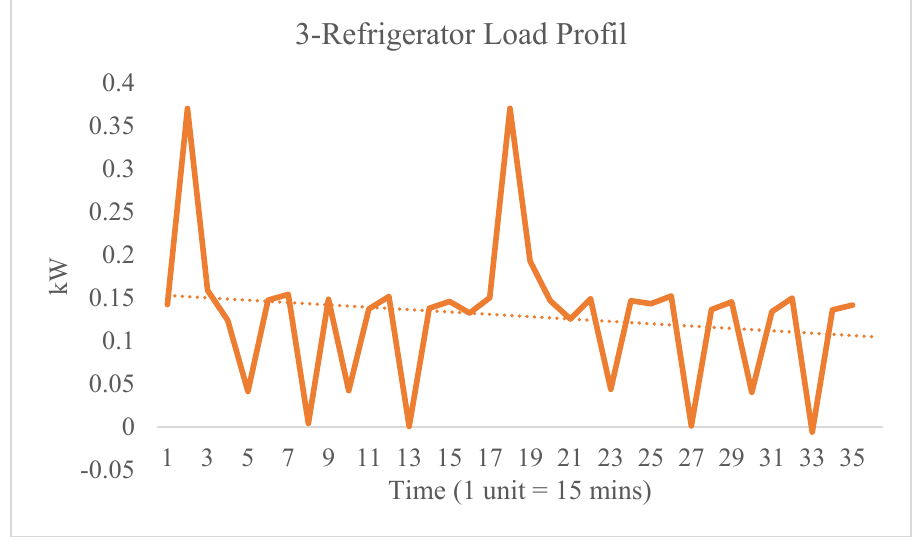
Figure 6. Load profile of refrigerator. Central air conditioning: The use of this device depends on the weather and ambient temperature and is non-transferable (Figures 7 and 8).